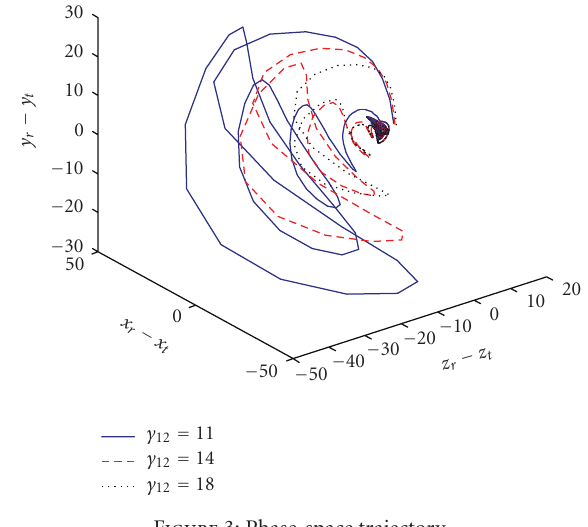
Figure 3: Phase-space